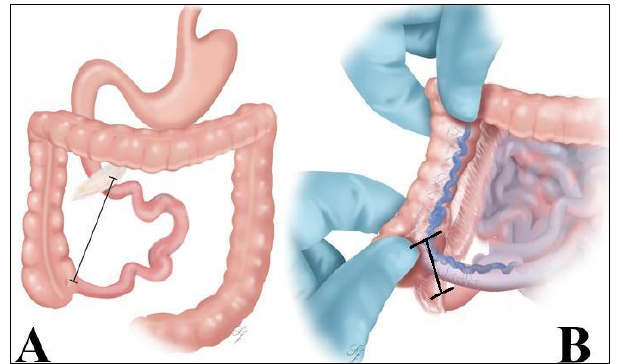
Figure 4: Mesenteric root in ‘normal’ isolated duodenal nonrotation (re-drawing from Stringer DA, Babyn PA, eds. Pediatric Gastrointestinal Imaging and Intervention [4] ) (A) and mesenteric root in our patient (B). The long black lines